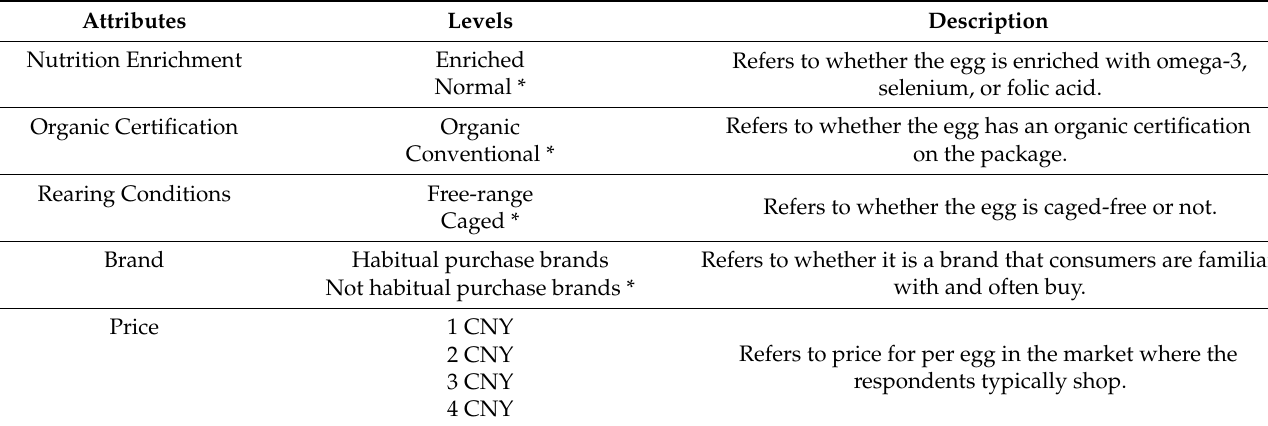
Table 1. Attributes and levels used in the choice